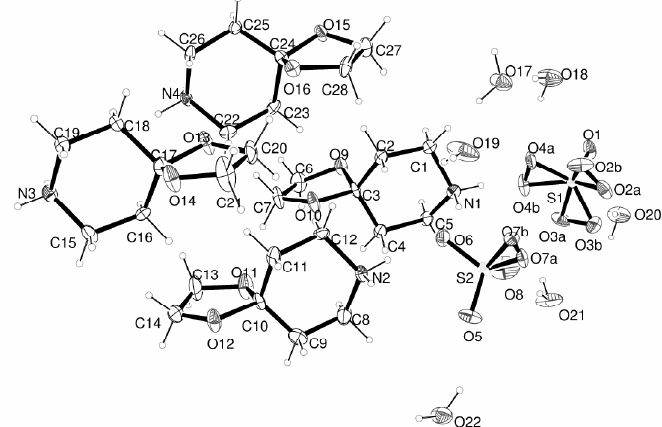
H O NH ) (SO ) .6H O 7 12 2 2 4 4 2 2